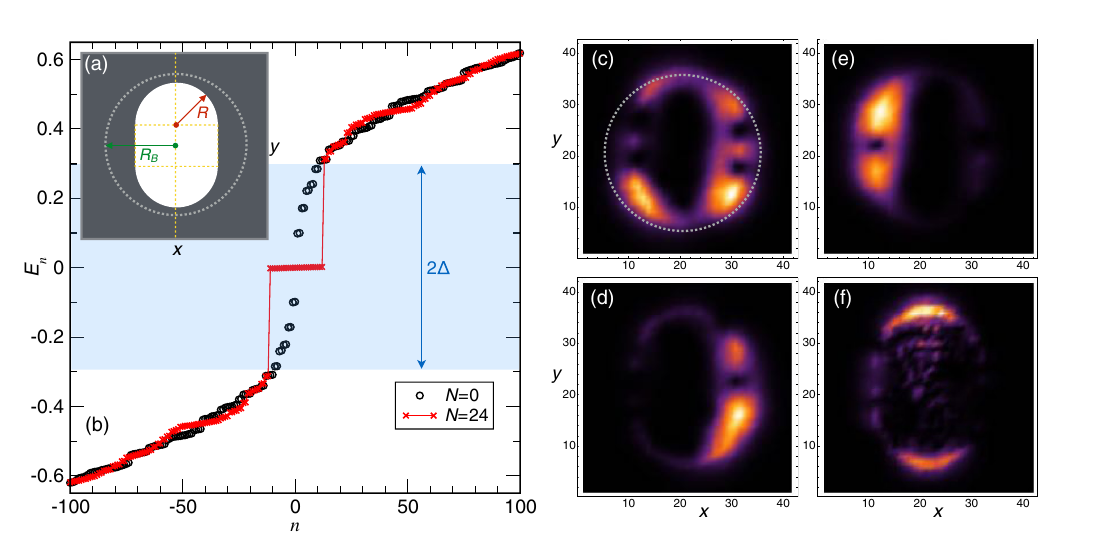
FIG. 4. Numerical simulations of the BdG Hamiltonian Eq. (4.5). (a) Stadium-shaped hole geometry employed in the simulations. R parametrizes the hole size whereas R denotes the radius inside which the magnetic field is nonzero. (b) Energy levels E B Hamiltonian Eq. (4.5) calculated for N ¼ 0 and N ¼ 24 . Energies have been sorted in ascending order and plotted as a function of their integer index n . The shaded band represents the SC gap region. (c) – (f) Density plots of the typical zero-mode wave function amplitudes for N ¼ 24 . The dashed circle in (c) has radius R . The following parameters are used to obtain these results: λ ¼ 1 , m ¼ 0 . 5 , Δ 0 ¼ 0 . 3 , B μ ¼ w 0 , w 0 . 1 , L ¼ 42 , R ¼ 10 , and R 15 μ ¼ λ ¼ w Δ ¼ B ¼